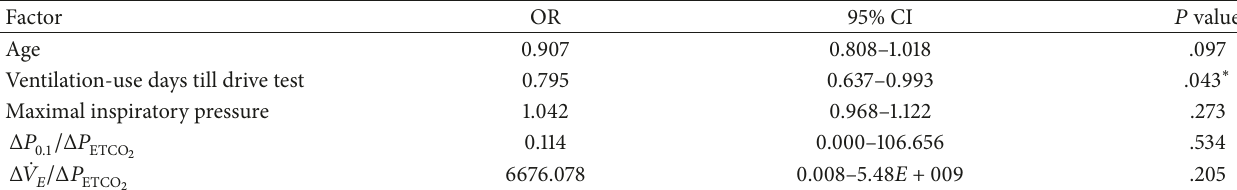
Table 3: Multivariate analysis of possible factors with weaning success.